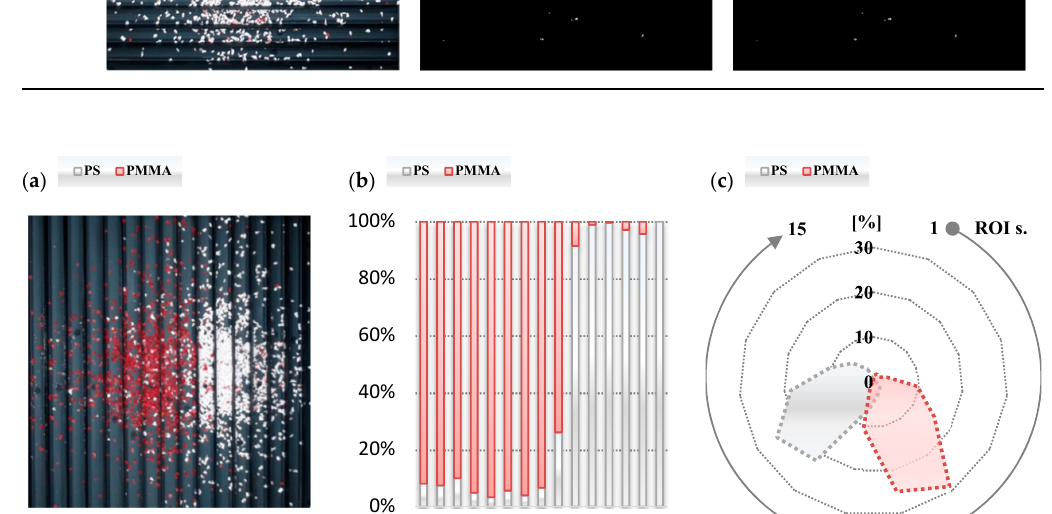
Figure 12. Results of processing the raw image ( a ); percentage material content in each ROI ( b ) and percentage material content related to total amount of each material ( c ) for the tribocharging mode.